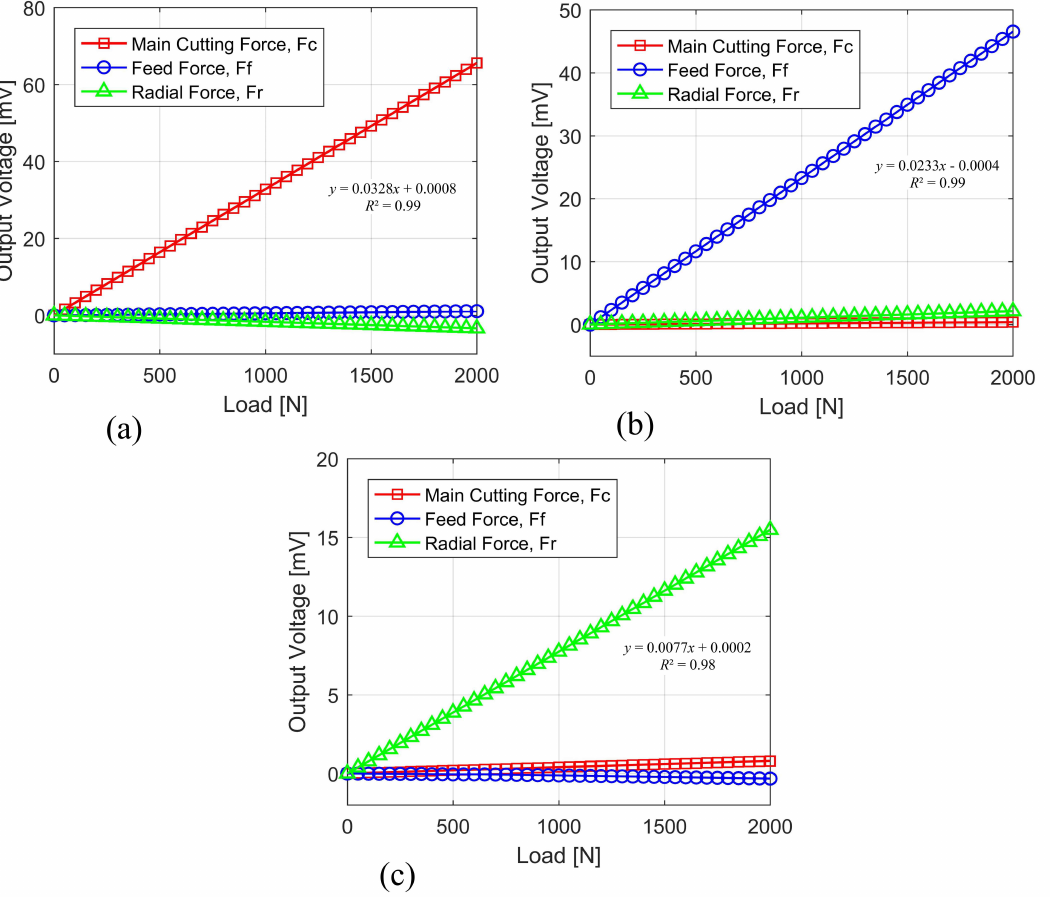
Figure 9. Dynamometer calibration curves: ( a ) F x direction; ( b ) F y direction; ( c ) F z direction. Table 2. Linearity, hysteresis, and repeatability errors for each axis of the dynamometer. Force